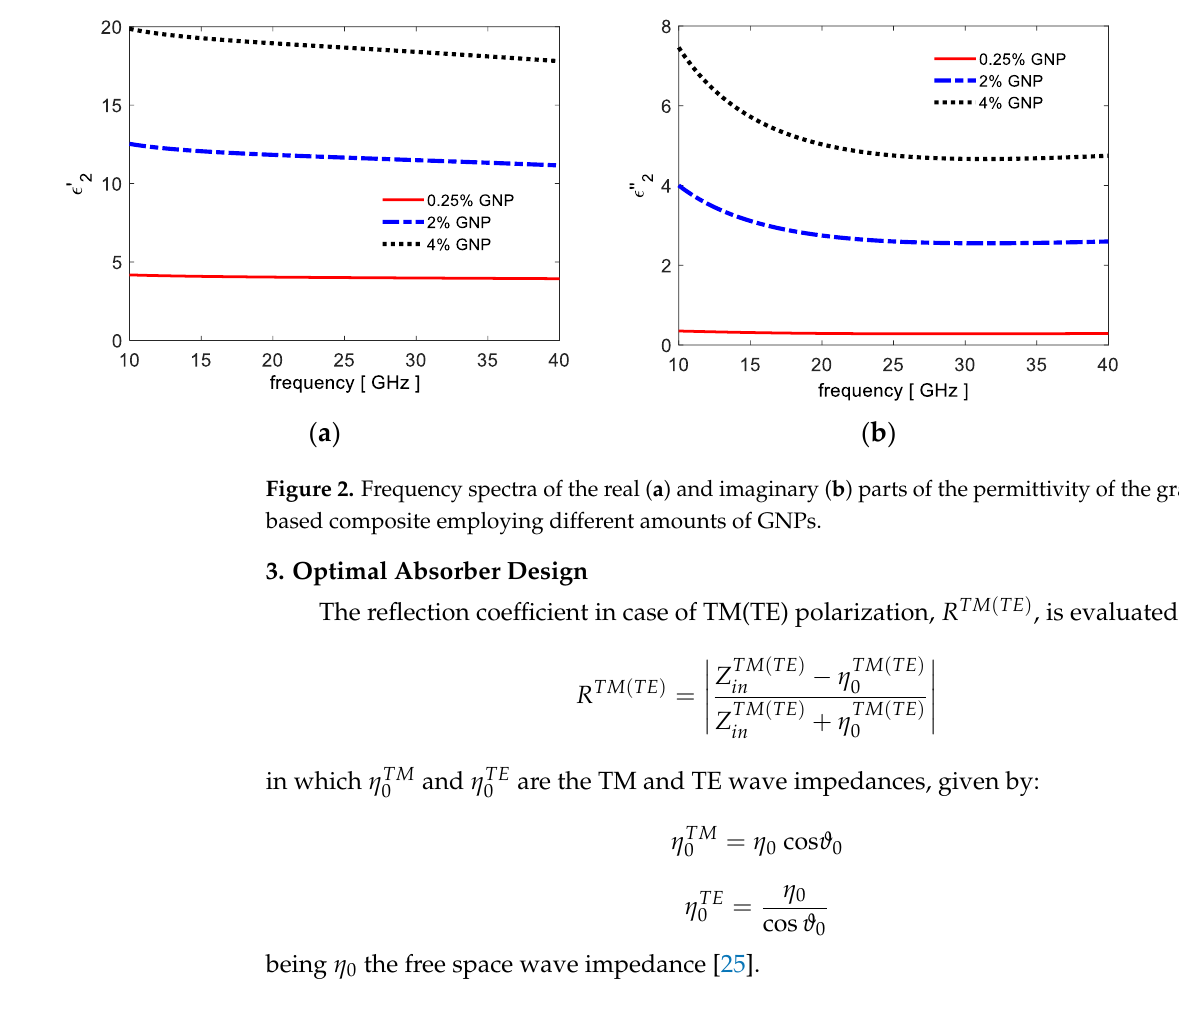
Figure 1. Absorber structure consisting of a PEC-backed polymer dielectric spacer (layer 1) and a graphene-based lossy sheet (layer 2). E iTM(TE) and H iTM(TE) are the incident electric and magnetic fields in case of TM or TE polarizations.